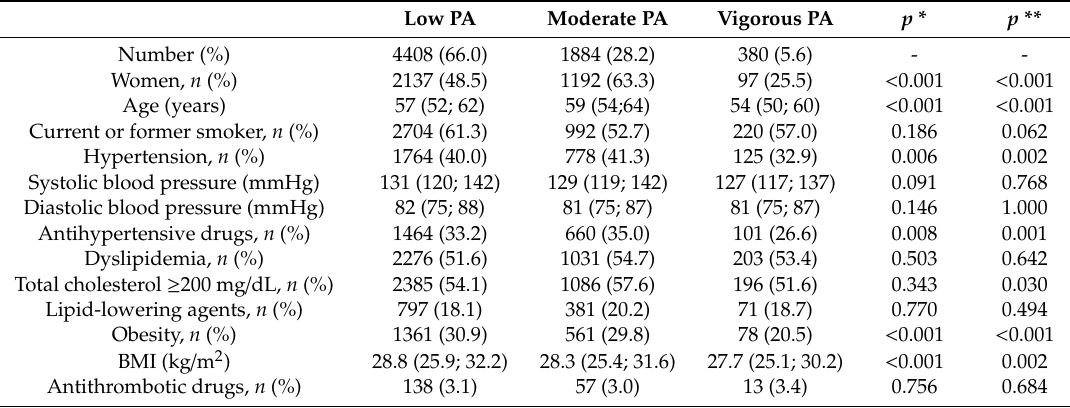
Table 1. Main clinical characteristics and comorbidities of the entire study population according to their physical activity practice.